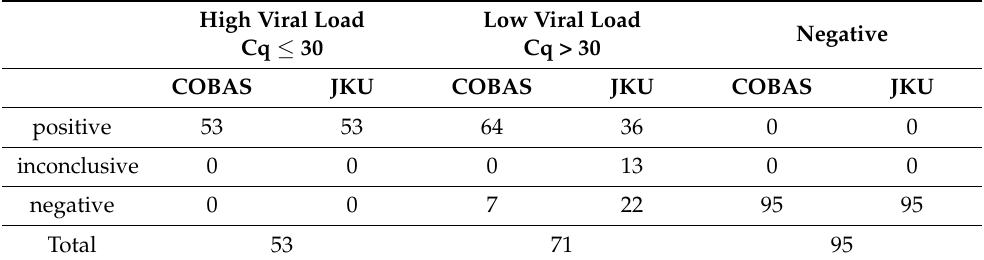
Table 5. Assay sensitivity.